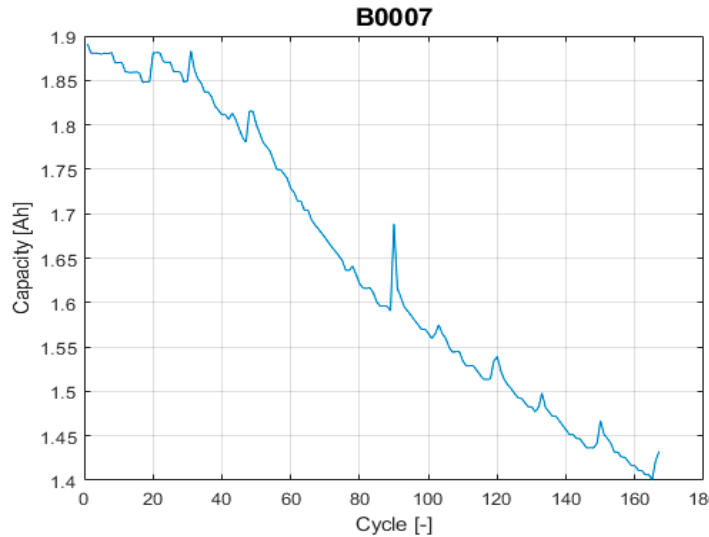
Figure 3. The input data with low uncertainty.